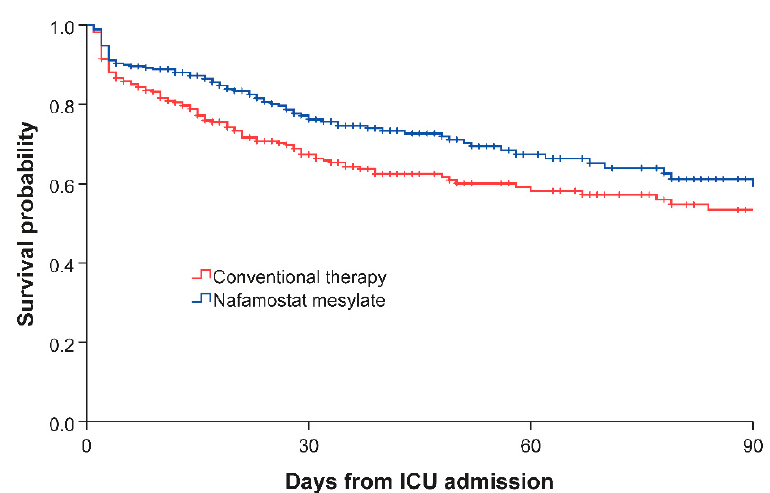
Figure 2. Survival curves of the nafamostat mesylate and conventional therapy groups. ICU: intensive care unit.